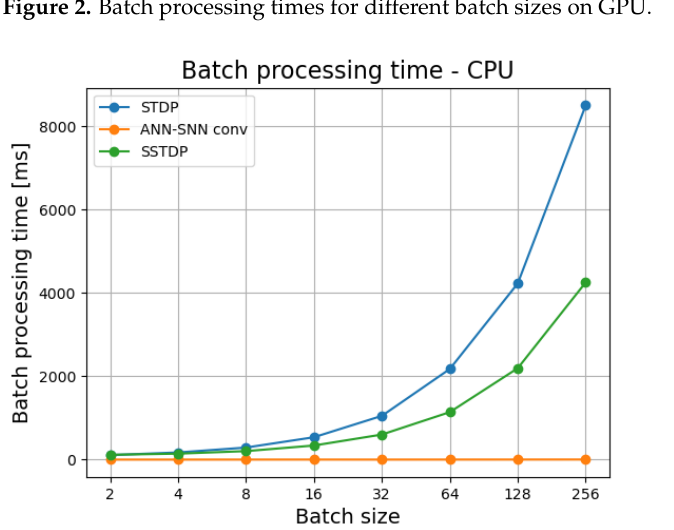
Figure 3. Batch processing times for different batch sizes on